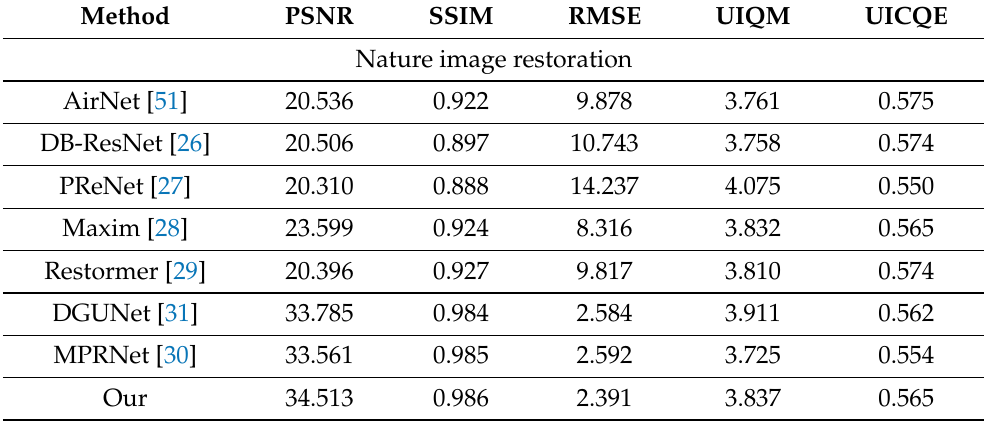
Table 2. Comparison results of UIR-Net with other SOTA methods on the MSIRB